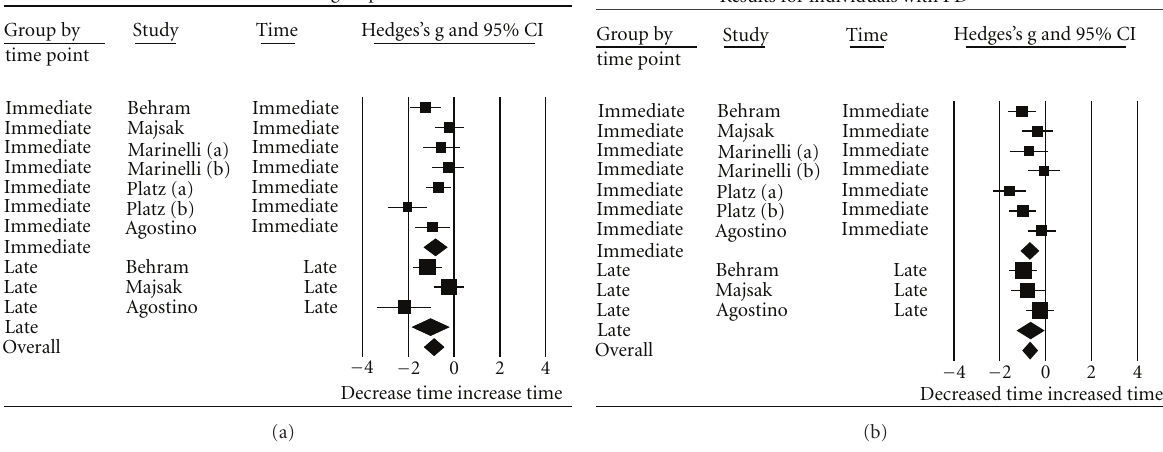
Figure 1: Forest plots of all the included studies for the control group (a) and the individuals with PD (b) including the time the results were acquired, Hedge’s g, and 95% confidence interval (CI) for the control group. Each box and corresponding horizontal line represents the overall mean and confidence intervals in the movement time. The area of each box is proportional to the inverse of that study’s variance. The horizontal line represents the 95% CI for each individual study. A diamond is used to depict overall mean e ff ect size (center of the diamond) along with its CI (width of the diamond)